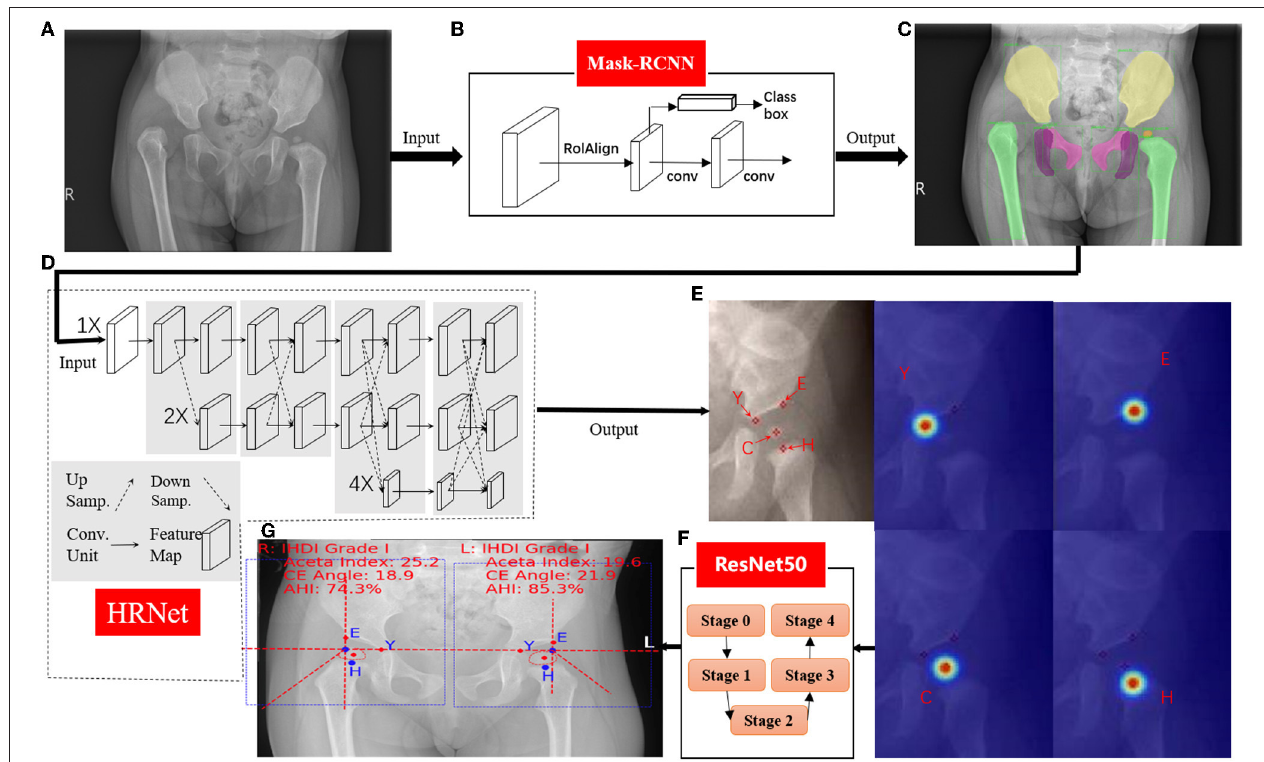
FIGURE 3 | Hip joint segmentation and landmark detection heat map. (A) Hip joint x-ray initial image. (B) The flow-process diagram of Mask-RCNN. (C) The segmentation effect of the hip joint (different colors indicate different bones). (D) The flow-process diagram of HRNet. (E) Process heat map of four landmark extraction. (F) The flow-process diagram of ResNet50. (G) Angle and line measurements.